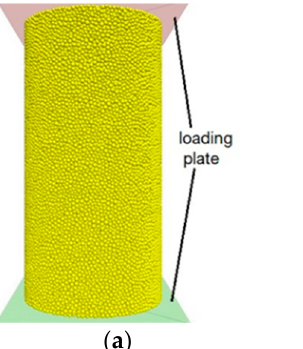
Figur e 8 . Numerical models: ( a ) unconfined compression test; ( b ) splitting test.